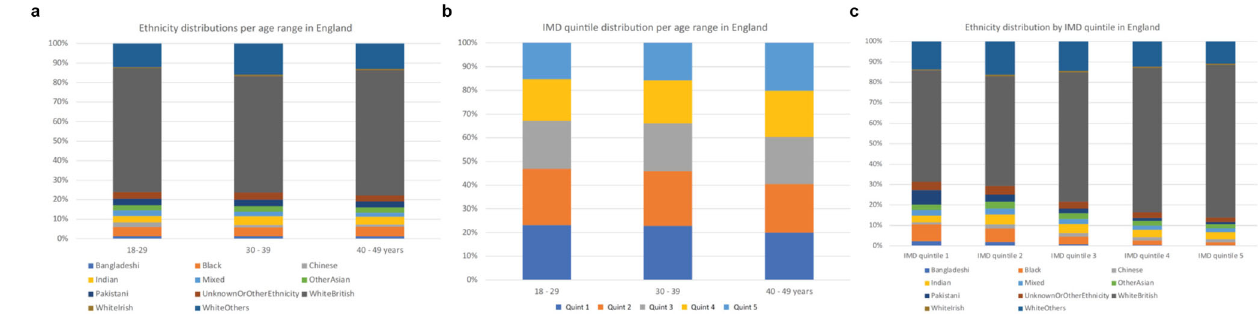
Fig. 4 | Distribution across the strata of maternal age, ethnicity and IMD by the other characteristics. a Distribution of ethnicity according to maternal age. b Distribution of IMD quintile by maternal age, with IMD 1 representing the most deprived quintile. c Distribution of ethnicity by IMD